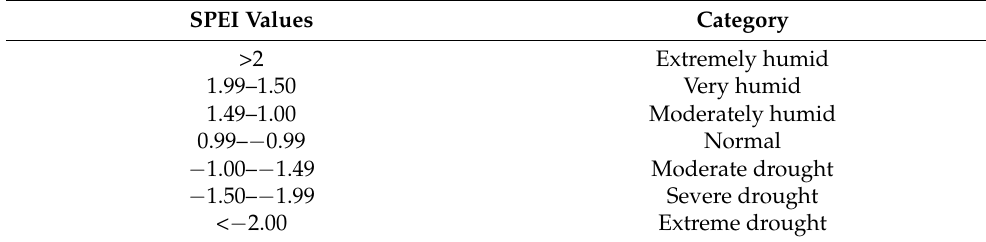
Table 1. Categorization of the SPEI